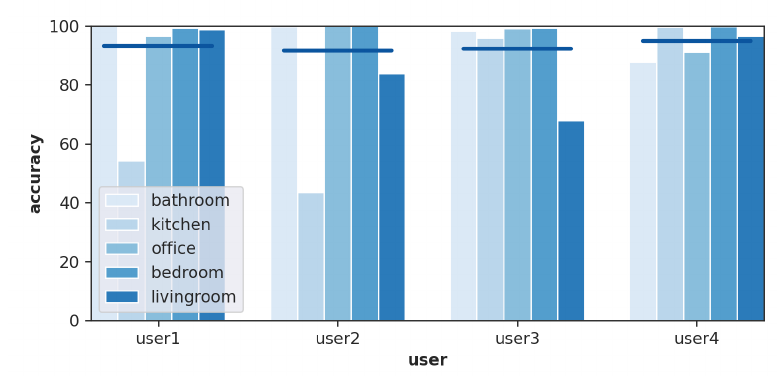
Figure 11. Results of the fingerprint method when using automatic training. Accuracy is the percentage of times the system is able to correctly estimate the room with respect the ground